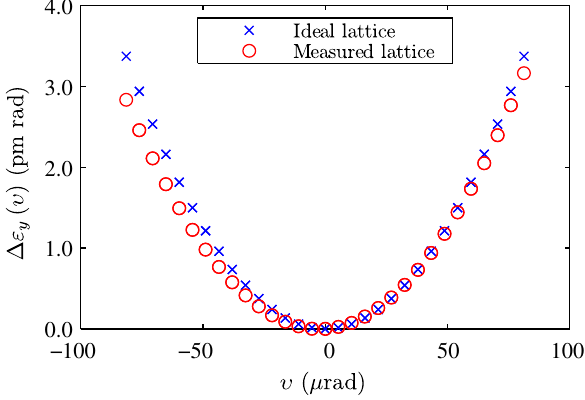
FIG. 11. Simulation of increase in equilibrium vertical emit- tance Δ ε y ð υ Þ ¼ ε y ð υ Þ − ε y ð 0 Þ for closed angular bumps through one sector of the AS storage ring, for two lattices. The ideal lattice has no magnet misalignments and no skew quadrupole compo- nents. The measured lattice includes upright and skew quadru- pole errors fitted to a measured orbit response matrix of the AS storage